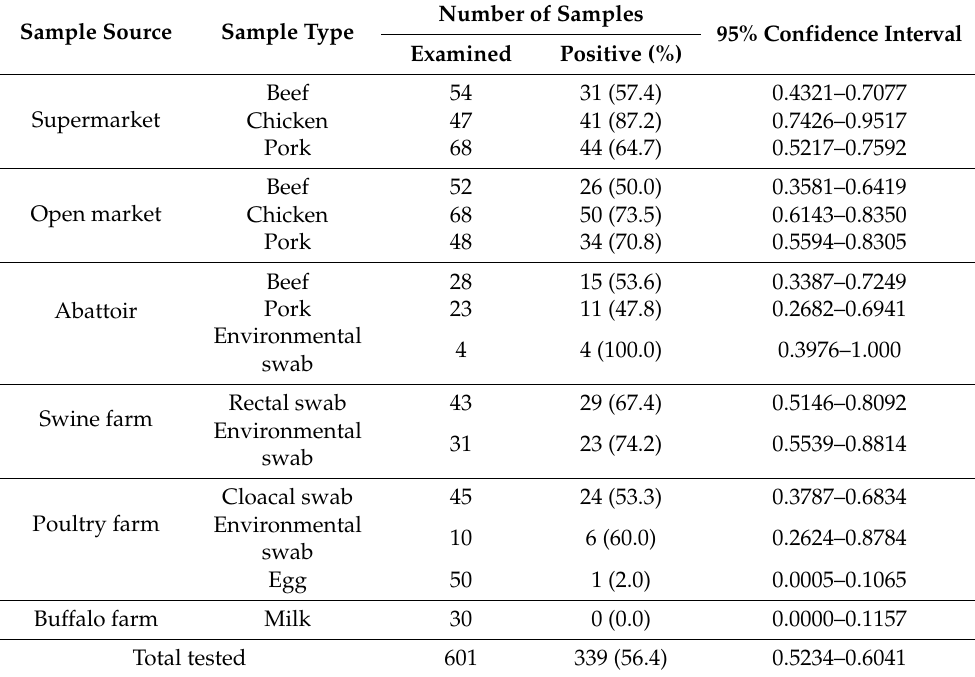
Table 1. Prevalence of Escherichia coli in food-producing animals and their food products.